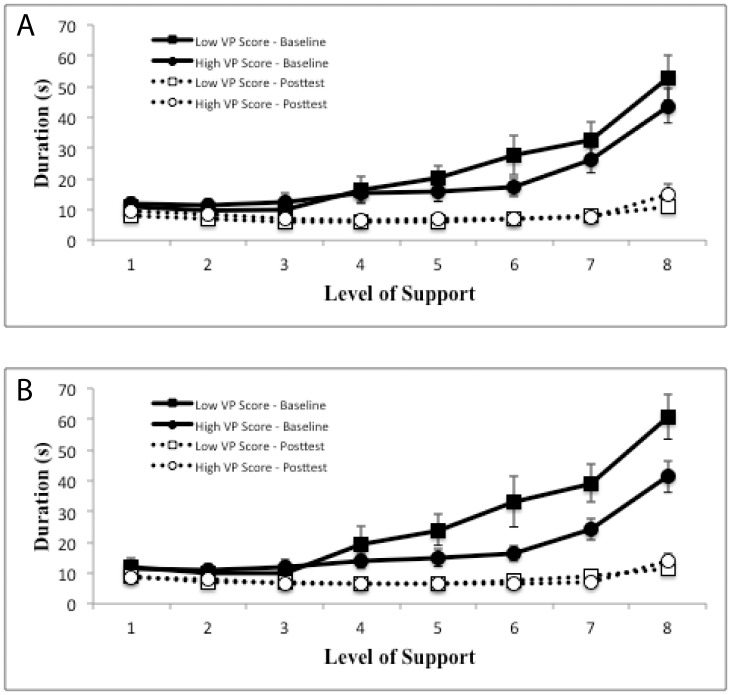
Mean trial durations as function of session, support level, and VP score.A) Mean duration computed by VP scores (high or low) relative to the median score as a function of session (baseline, posttest) and support level (1 =  high, 8 =  low). B) Mean durations computed by VP scores (high or low) relative to the average as a function of session (baseline, posttest) and support level (1 =  high, 8 =  low).